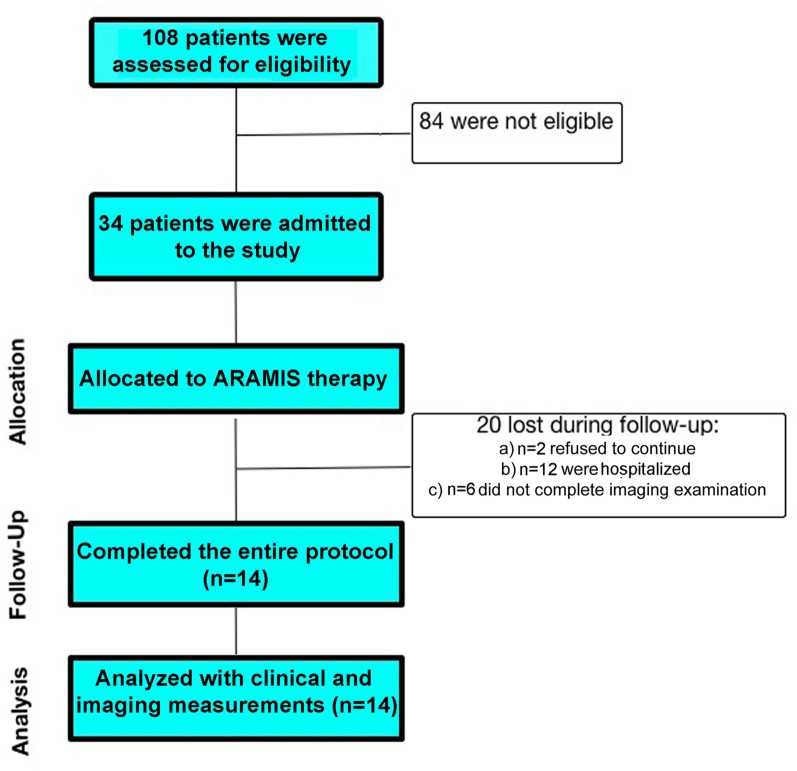
Flow diagram of participant recruitment and participation in the study: stroke patients participated in an individualized robotic-assisted neurorehabilitation program (ARAMIS system).